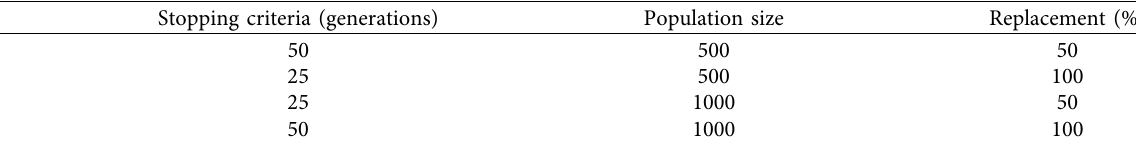
Table 9: Parameter tuning data.